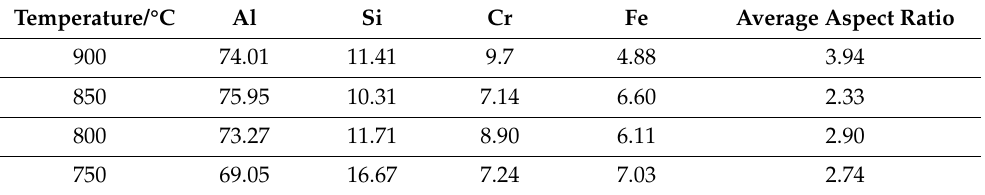
Table 1. Average composition (atm.%) and average aspect ratio of particles of the first type. Temperature/°C